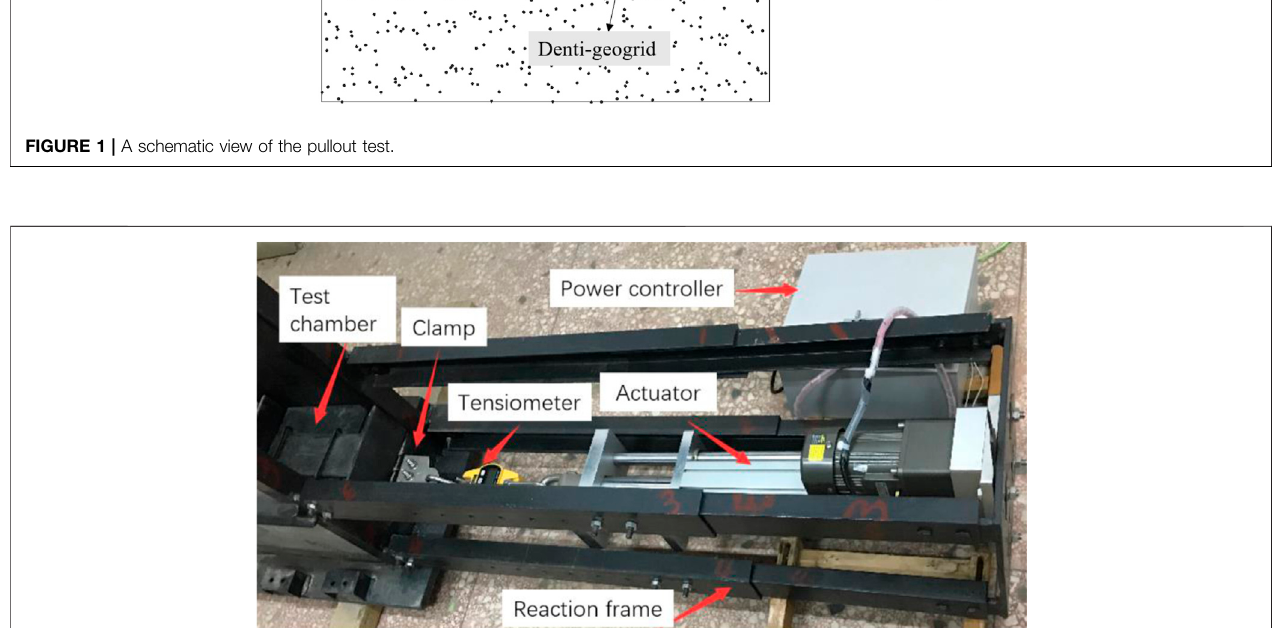
FIGURE 2 | The pullout system.